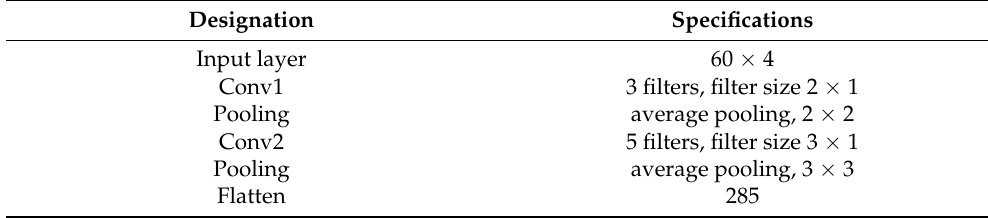
Table 6. Details of the CNN